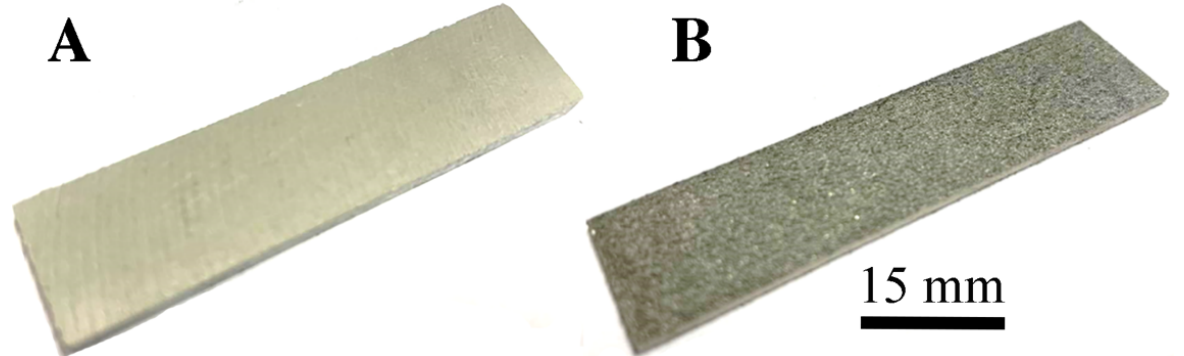
Figure 3. Cast ( A ) and DMLS ( B ) AlSi10Mg alloy samples.